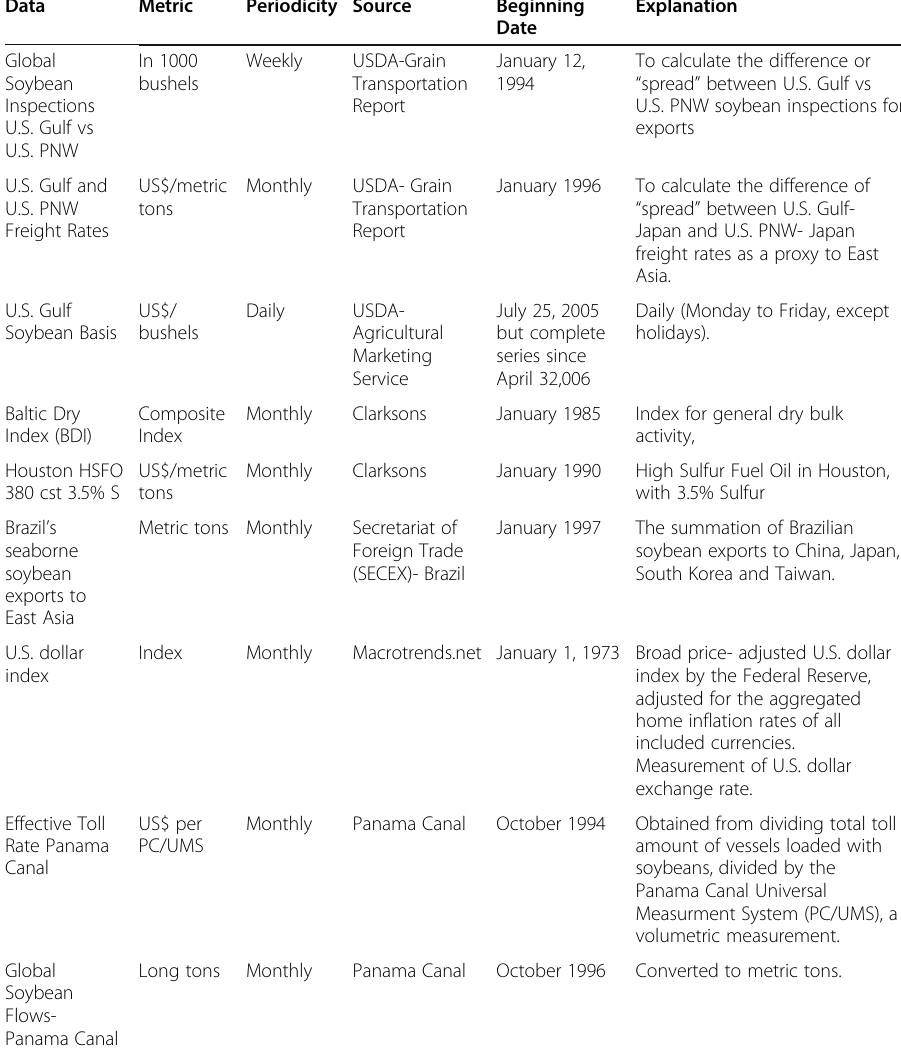
Table 1 List of data sources for the study Data Metric Periodicity